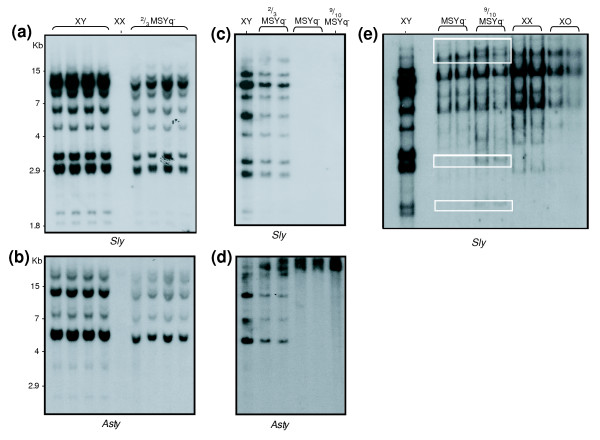
Multiple copies of Sly and Asty/Asty(rec) map to MSYq. (a, b) Southern of EcoRI digested DNAs showing hybridization of Sly probe MTnH-K10 and Asty exon 4 probe, respectively, to multiple male specific bands, with reduced hybridization to all bands in 2/3MSYq- males. (c, d) Southern of EcoRI-digested DNAs from 2/3MSYq-, 9/10MSYq-, and MSYq- males together with control XYRIII, showing reduced hybridization in 2/3MSYq- males and an apparent absence of hybridization to Y specific bands in the males with more extensive MSYq deficiency. (e) Two week exposure of a Southern blot of EcoRI digested DNAs from 9/10MSYq- and MSYq- males together with XO and XX females, and an underloaded XYRIII control. X derived fragments now cross-hybridize with the Sly probe (dosing with the number of X chromosomes), but in addition there are at least three male specific bands (outlined) retained in the 9/10MSYq- males that are absent in the MSYq- males.